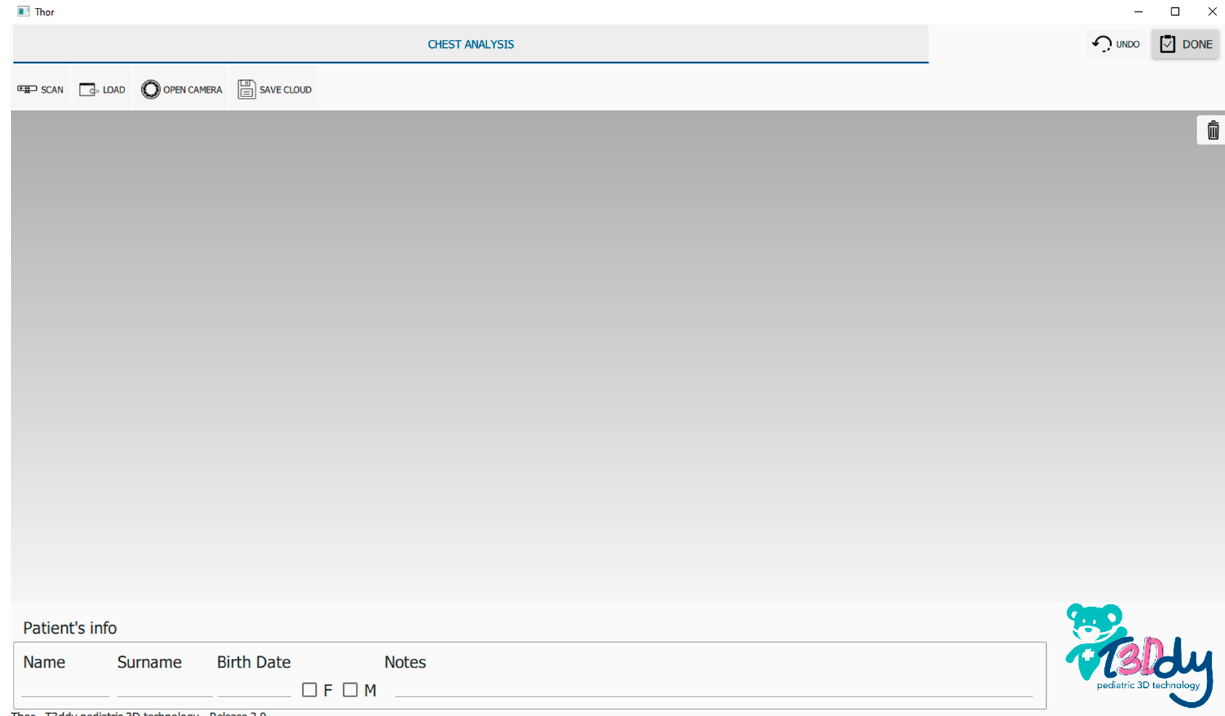
Figure 6. Simplified GUI for patient